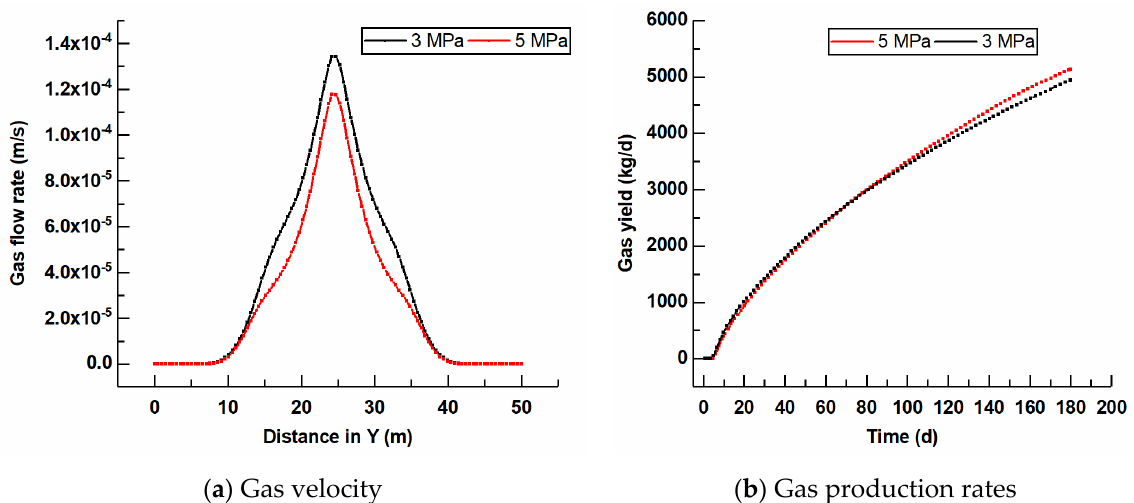
Figure 11. Gas velocity and gas production rates in the production well when the gas flooding pressure is 5 and 3 MPa, respectively.